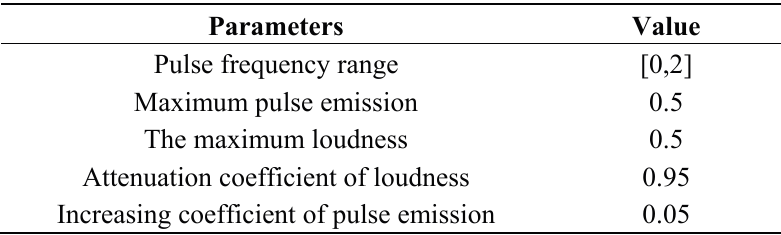
Table 5. The parameters setting of bat algorithm